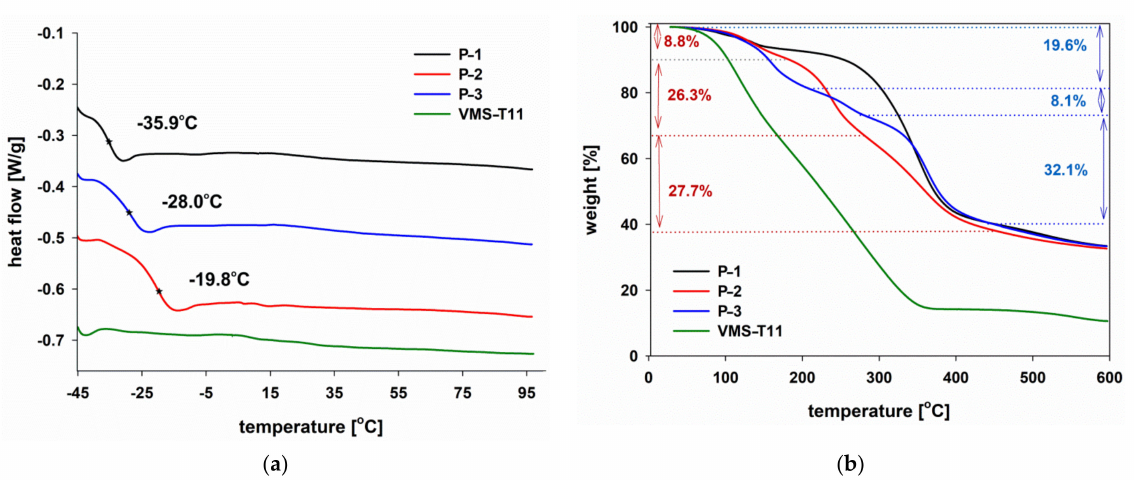
Figure 1. Thermal characteristics of the functionalized silicones: ( a ) Differential Scanning Calorimetry (DSC), 3rd heating run; ( b ) Thermogravimetric Analysis (TGA) in N 2 10 ◦